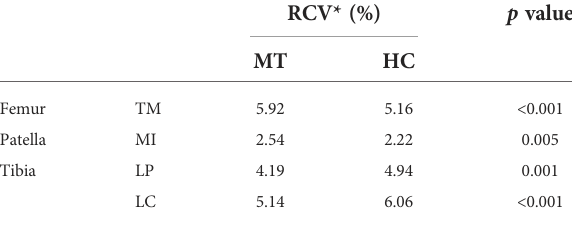
TABLE 3 Comparison of the relative cartilage volume percentage of the articular cartilage 21 subregions between the healthy control group and the meniscus tear group (only showing the subregions with signi fi cant differences).